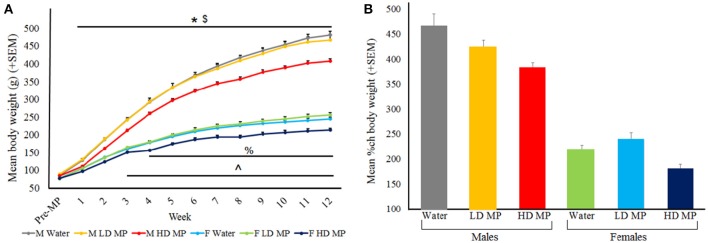
(A) Mean (+SEM) body weight by treatment week. Rats expectedly gained weight as they grew from adolescents into adults. Males expectedly gained more weight than females. HD MP treatment dose-dependently attenuated body weight throughout most of the treatment period. HD male rats weighed significantly less than water control males (*p < 0.05) and LD males ($p < 0.05) in treatment weeks 1–12. HD MP female rats weighed less than water control females in treatment weeks 4–12 (%p < 0.05) and less than LD MP female rats in treatment weeks 3–12 (∧p < 0.05). (B) Mean (+SEM) percent change in body weight from pretreatment to the final week of the experiment. HD MP attenuated weight gain, regardless of sex.